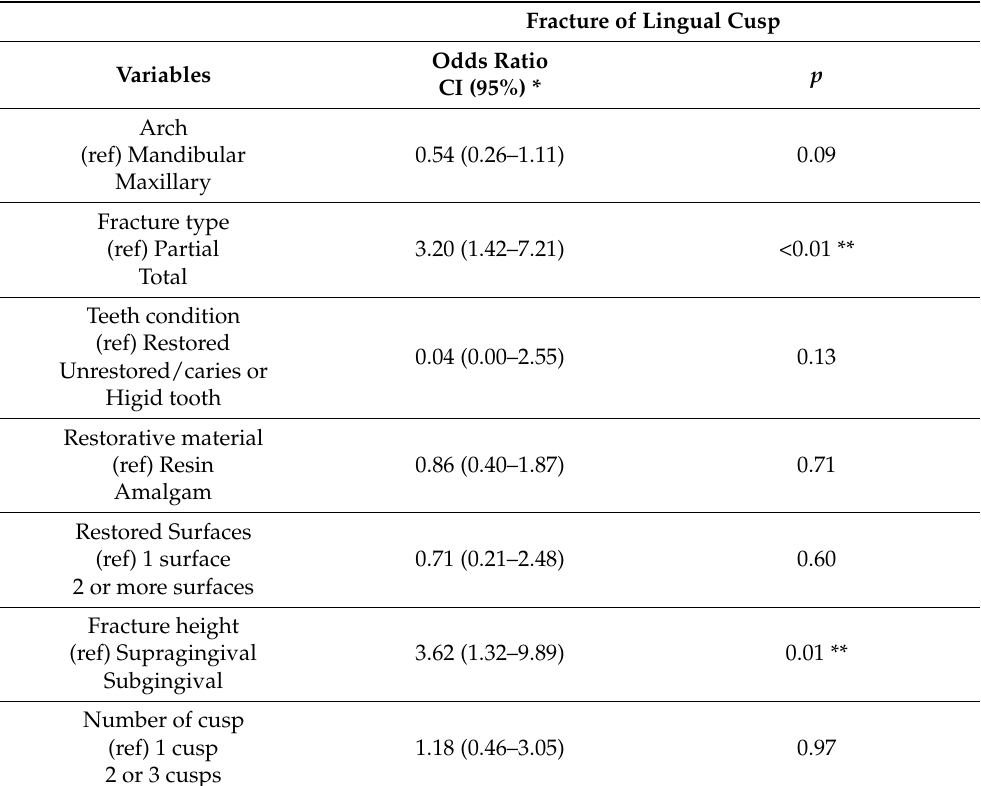
Table 3. Multiple-model logistic regression with the variables that presented p < 0.20 in the univariate regression (Table